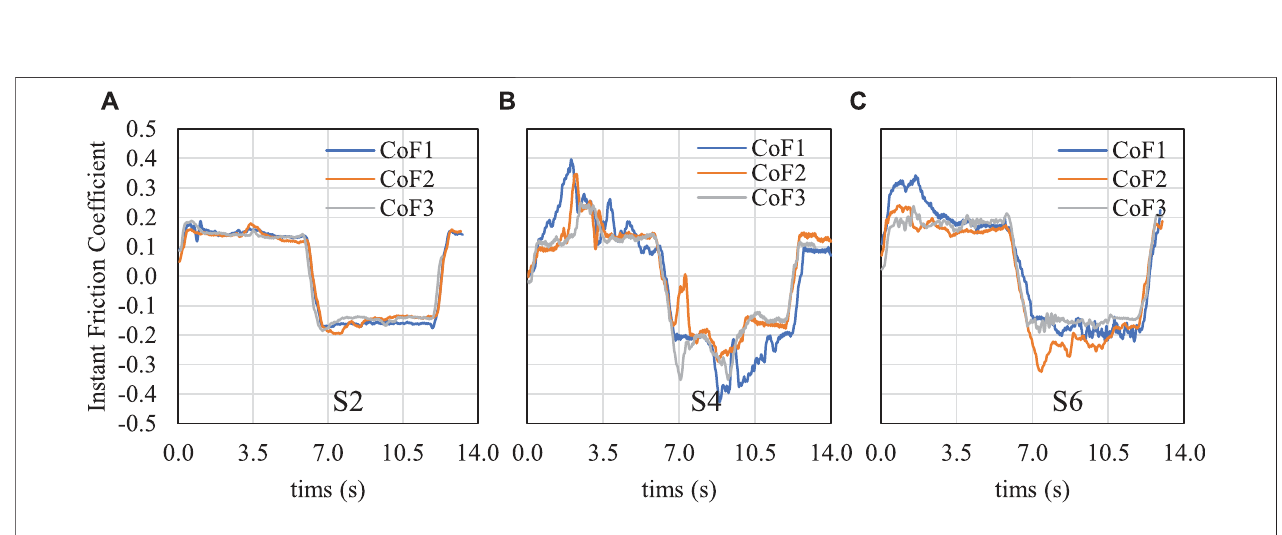
FIGURE 8 | Particle – wall friction for samples (A) S2, (B) S4, and (C) S6.